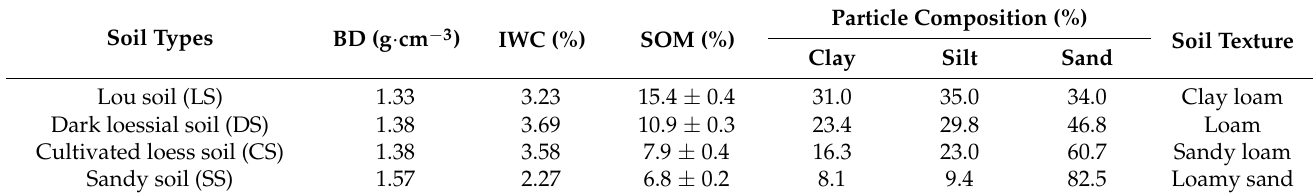
Figure 1. Location of the Chinese Loess Plateau and the region for soil sample collections. Table 1. Soil physical index.